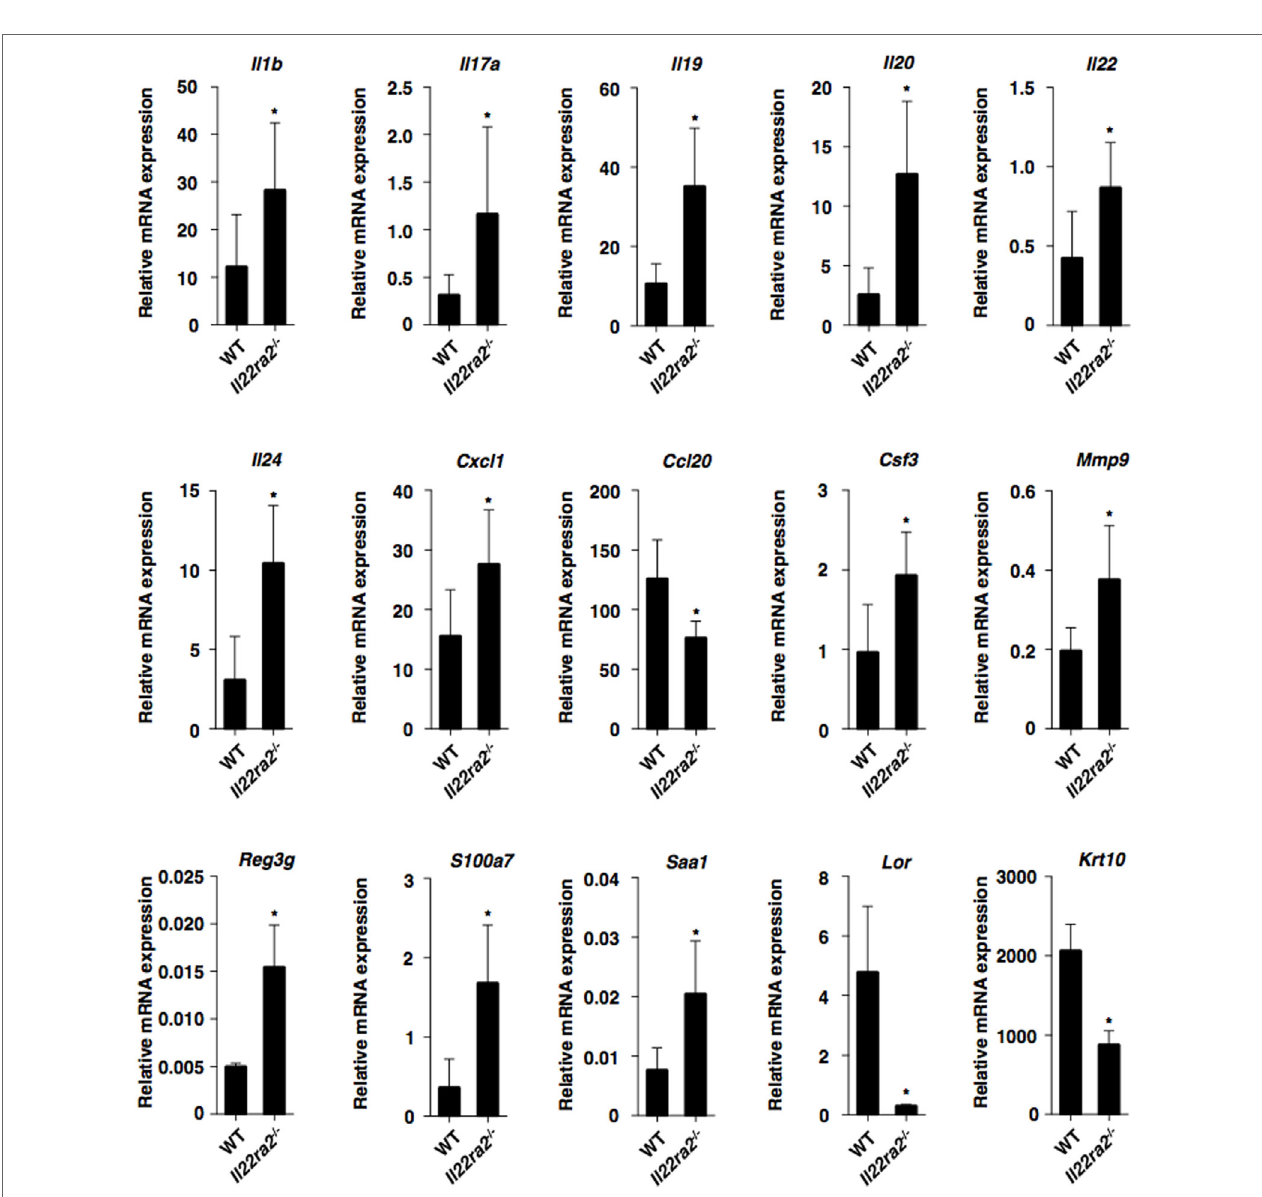
FigUre 2 | IL-22 binding protein deficiency promotes psoriatic inflammation. Transcriptional expression of cytokines, chemokines, and epithelial inflammation- related molecules in ear skin was analyzed by quantitative reverse transcription polymerase chain reaction at 8 days after topical application of imiquimod on the ear skin in wild-type (WT) mice ( n = 5) and Il22ra2 − / − mice ( n = 5), and expression was normalized to the Actb transcript. Data are the mean ± SD from three individual samples in a single experiment. * P < 0.01 compared with WT mice. All data are representative of at least three independent experiments.